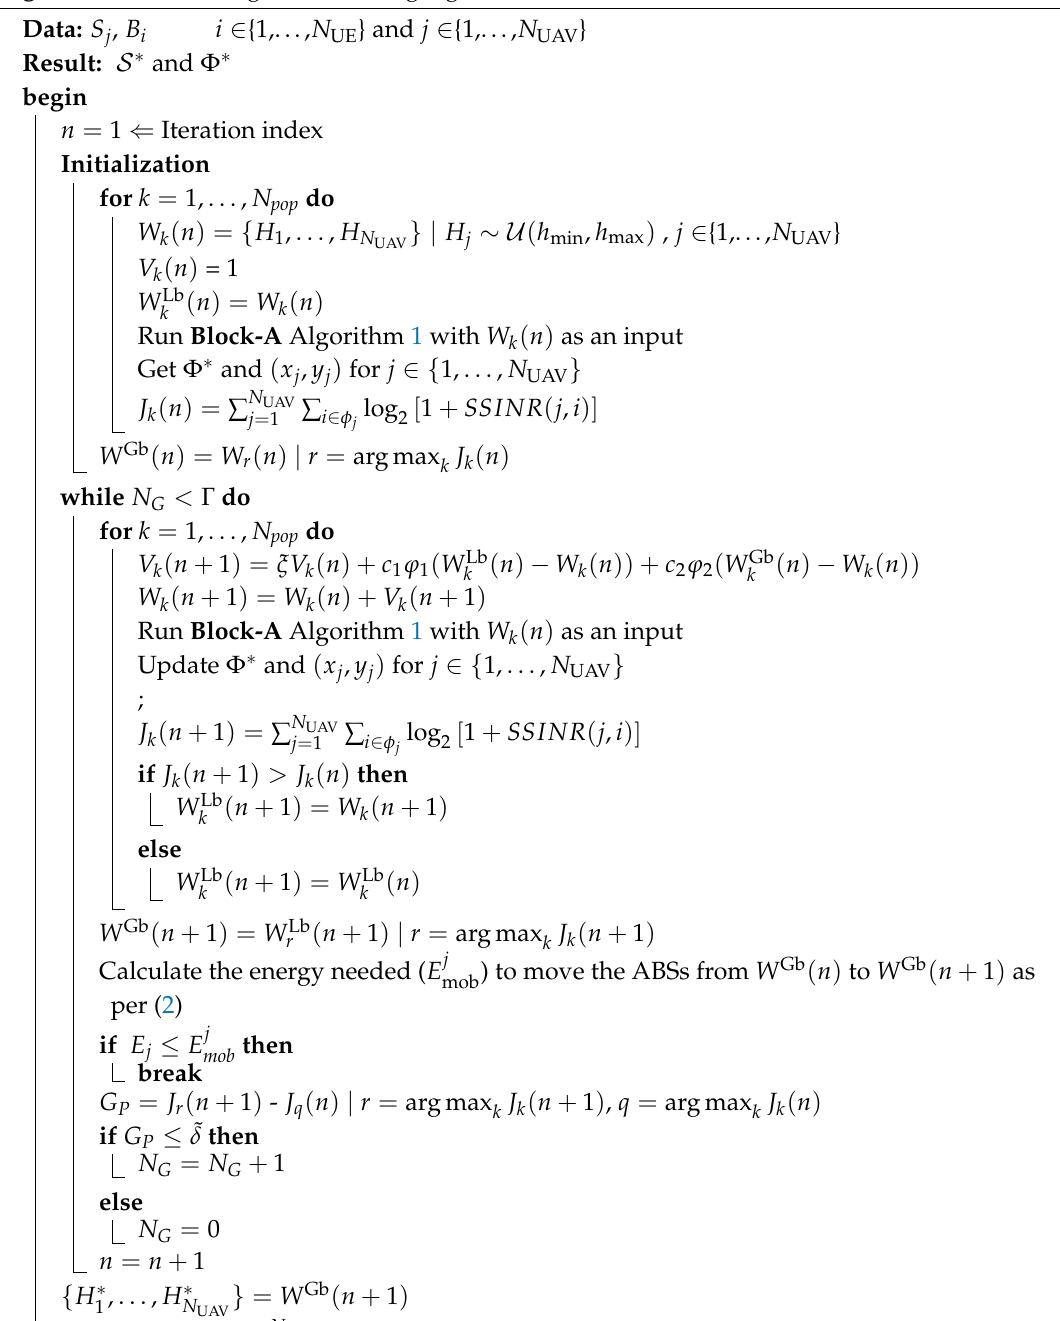
Algorithm 2: Clustering and matching algorithm with PSO Data: S j , B